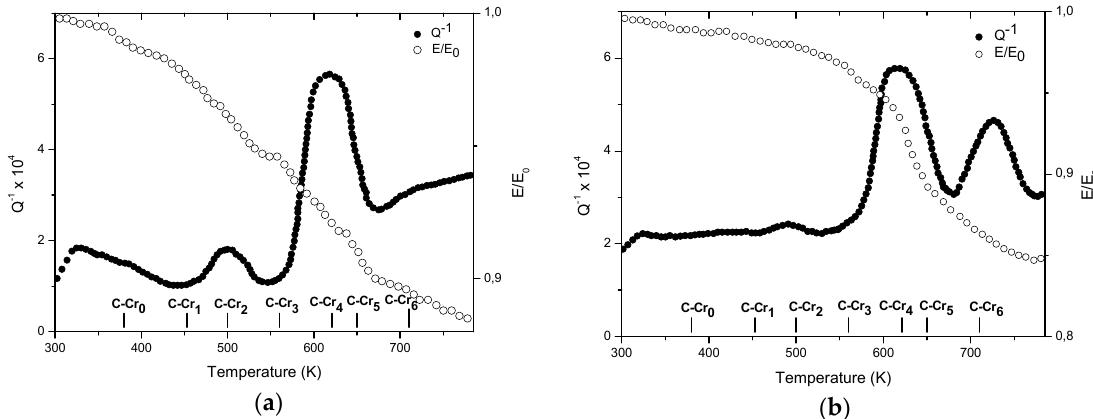
Figure 1. Q − 1 and E/Eo curves of the Cr martensitic steel after quenching from the austenitic field (1348 K) with a cooling rate of 3600 K/min ( a ) and 150 K/min ( b ). The resonance frequency f = 250 Hz. Data of these materials where already published in ref. [27] but the present curves obtained through VRA 1604 are more pricise in particular in the initial part.